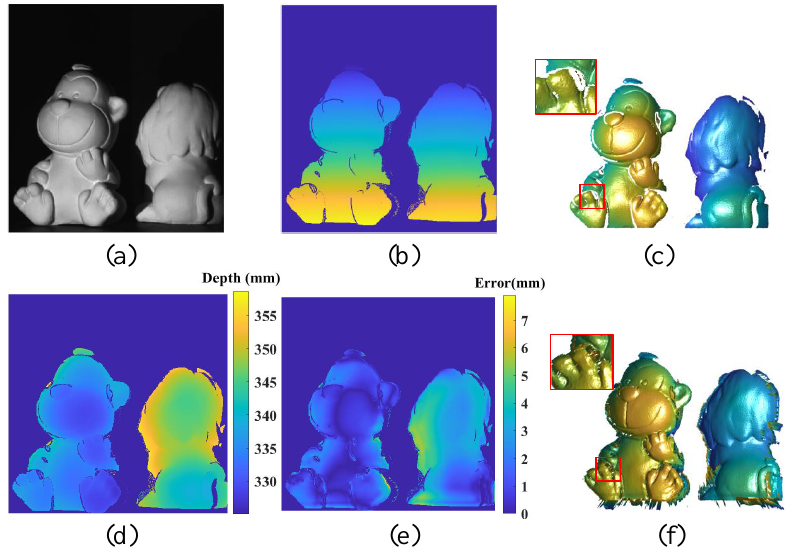
Figure 6. Effectiveness evaluation of the proposed model for scanning two objects in the real-world FPP system. ( a ) Texture image; ( b ) Unwrapped phase map; ( c ) 3D reconstructed geometry from